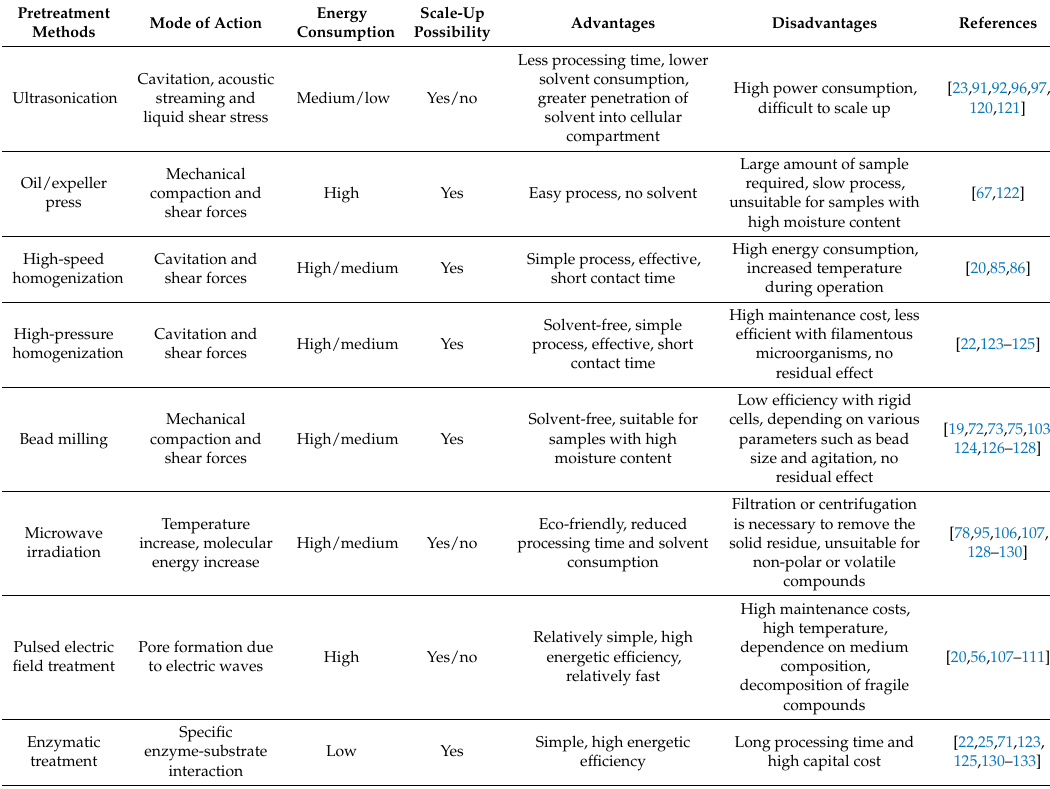
Table 2. Summary and comparison of various mechanical and non-mechanical pretreatment methods for cellular